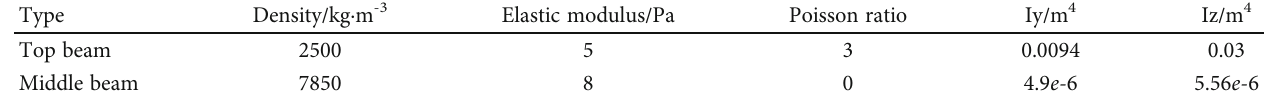
Table 8: Beam element